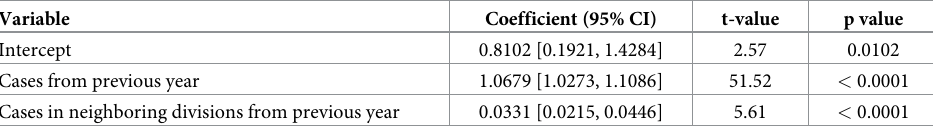
Table 2. Division-level predictive model